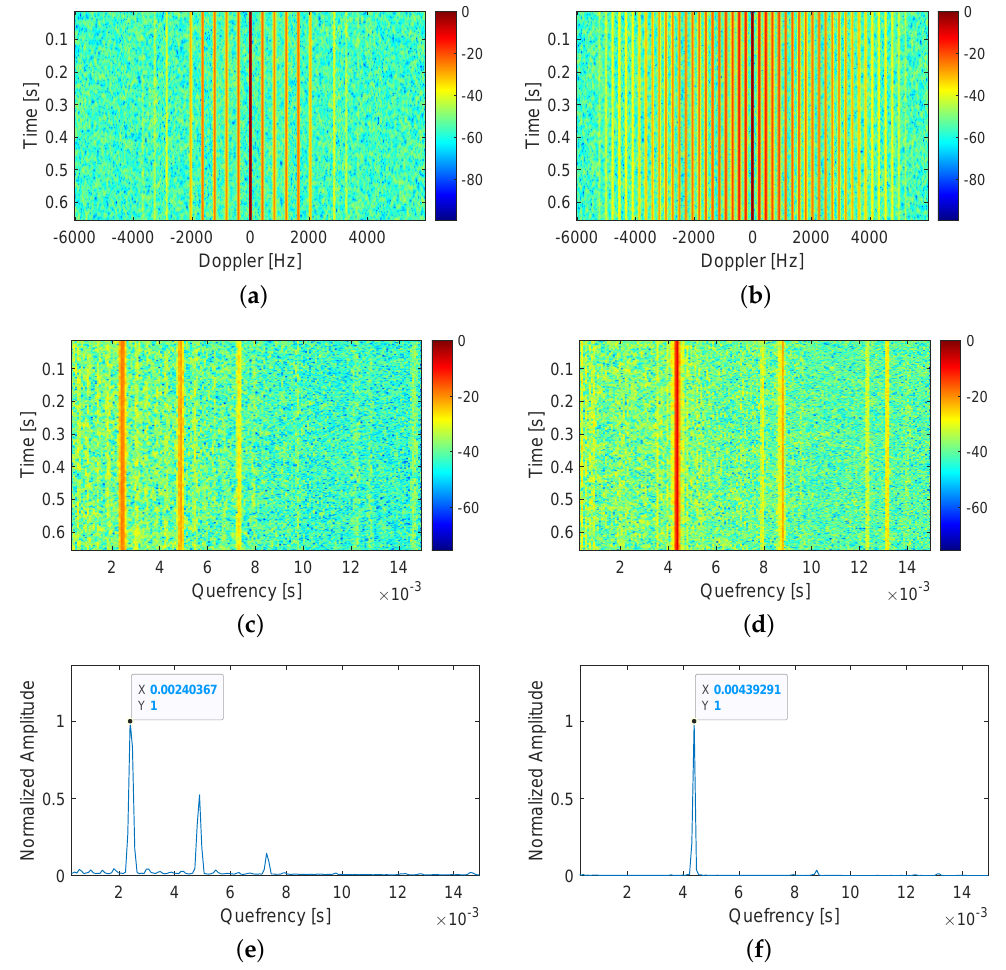
Figure 6. Simulation results obtained from a mosquito and a bee. ( a ) Spectrogram (mosquito). ( b ) Spectrogram (bee). ( c ) Cepstrogram (mosquito). ( d ) Cepstrogram (bee). ( e ) Projected cepstrogram (mosquito). ( f ) Projected cepstrogram